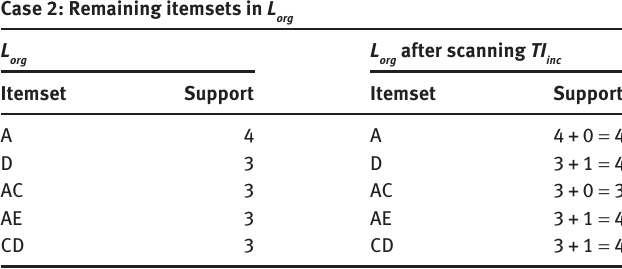
Table 8: Frequent Itemsets in Case 2.